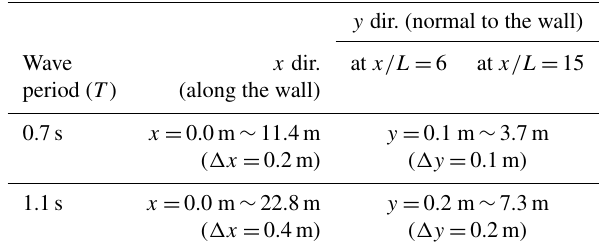
Table 2. Measuring points in hydraulic experiments. y dir. (normal to the wall) Wave x dir. at x/L = 6 at x/L =